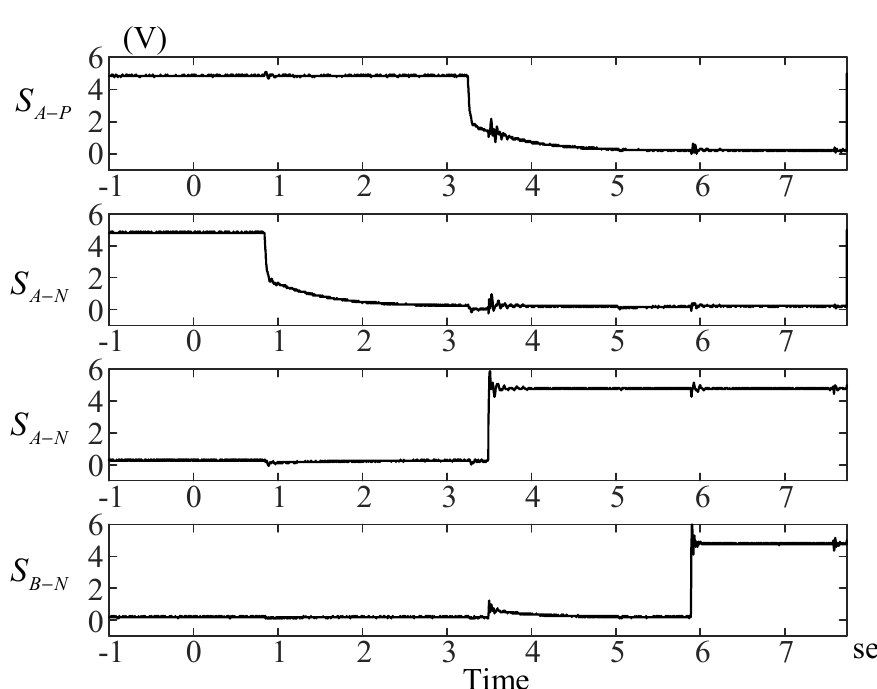
Figure 12. The measured waveforms of three-step commutation. Figure 13a demonstrates the measured sinusoidal speed command and the speed by using the PI and the CPC. Figure 13b shows the measured speed tracking errors between the speed command and the measured speed. The PI controller causes more speed errors than the CPC due to the PI controller’s delayed characteristics.